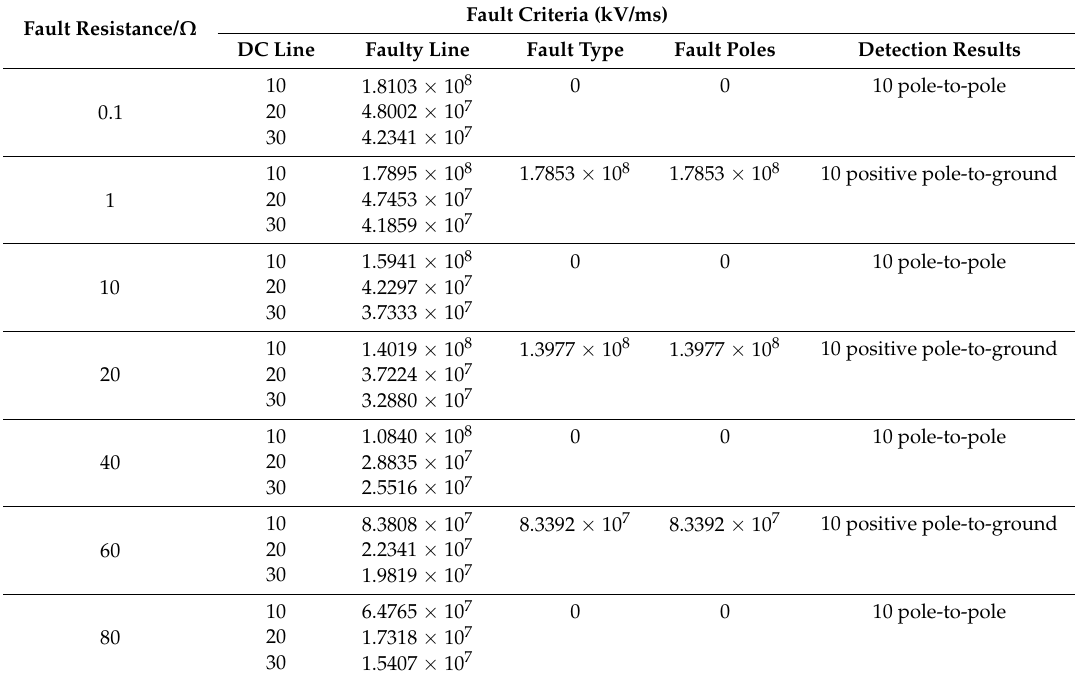
Table 3. Detection results of different fault